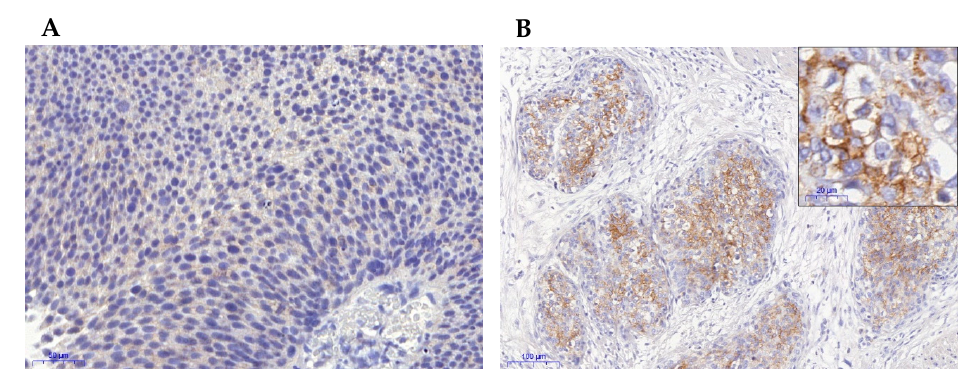
Figure 2: Representative images of FGFR3 immunohistochemistry: ( A ) FGFR3-negative case (Score 1); ( B ) FGFR3-positive case (score 3); (100 fold original magnification; inset: 400 fold